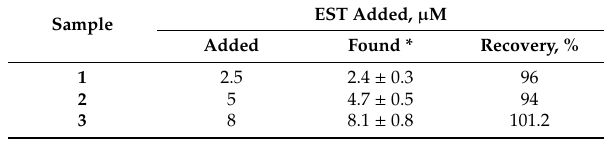
Table 2. Determination of EST in spiked urine samples using o -NPOE plasticized membrane sensors.